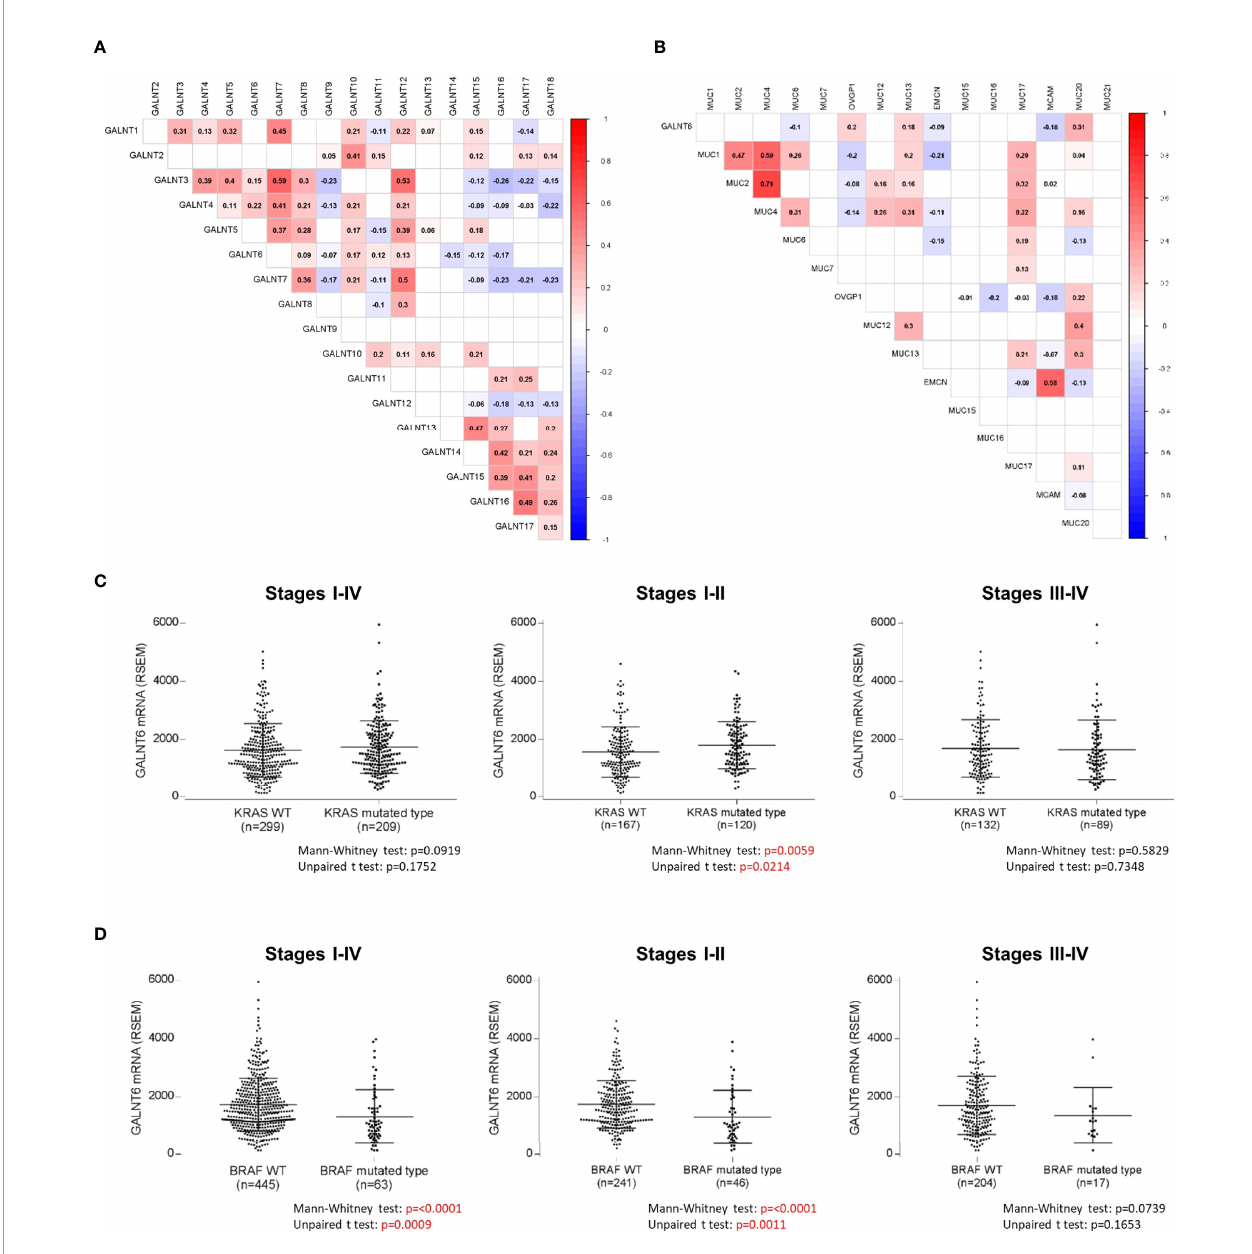
FIGURE 4 | Pairwise comparison of mRNA expression levels of (A) GALNT6 with GALNT gene family members and (B) GALNT6 with MUC mucin gene family members (positive and negative correlation coef fi cients are shown). Comparison of GALNT6 mRNA expression levels as a function of (C) KRAS mutations status or (D) BRAF mutation status. All data based on a 508-case TCGA colorectal cancer